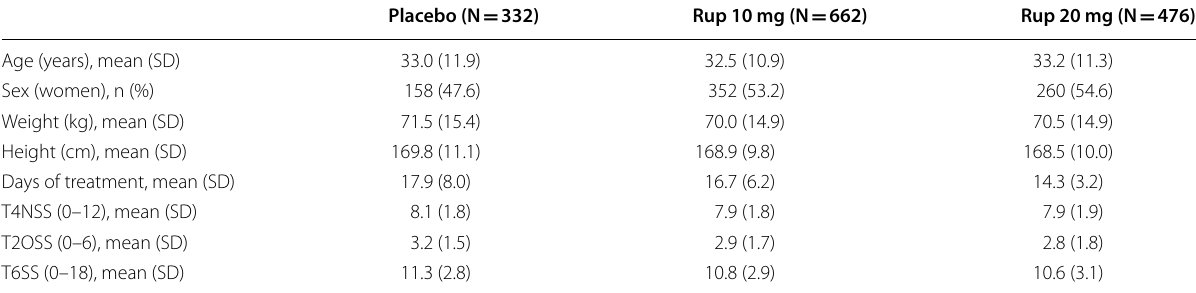
Rup Rupatadine, T4NSS Total 4 Nasal Symptom Score, T2OSS Total 2 Ocular Symptom Score, T6SS Total 6 Symptom Score, SD standard